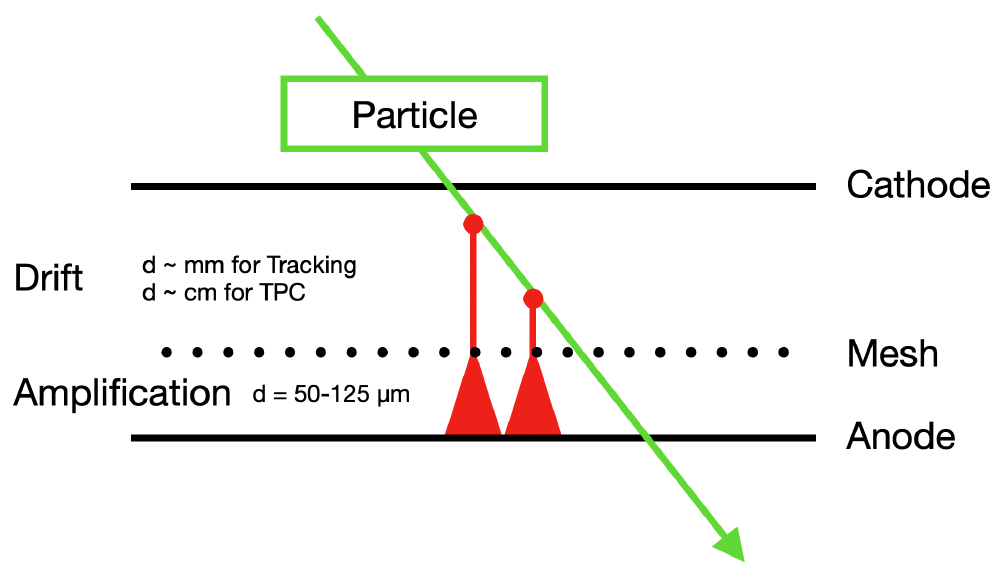
Figure 1. When a particle passes through the Micromegas detector, it ionises several atoms in the conversion volume, and the primary electrons drift to the amplification region. In the amplification region, an electron avalanche is